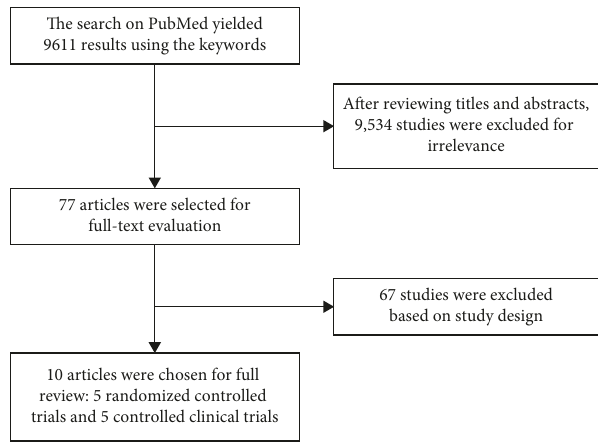
Figure 1: Process of selection of the